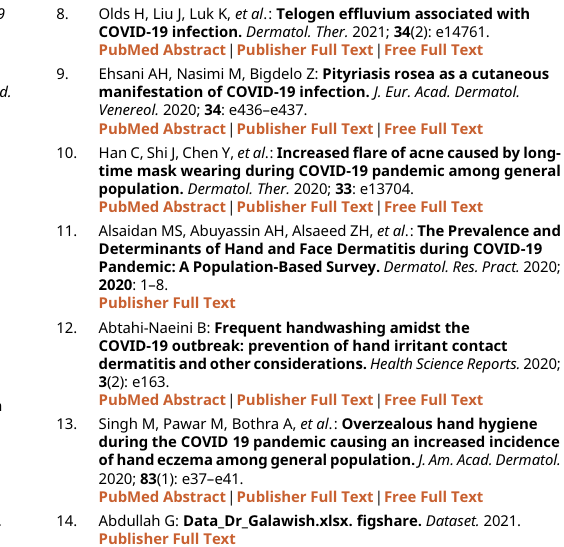
14. Abdullah G: Data_Dr_Galawish.xlsx. figshare. Dataset. 2021. Publisher Full Text